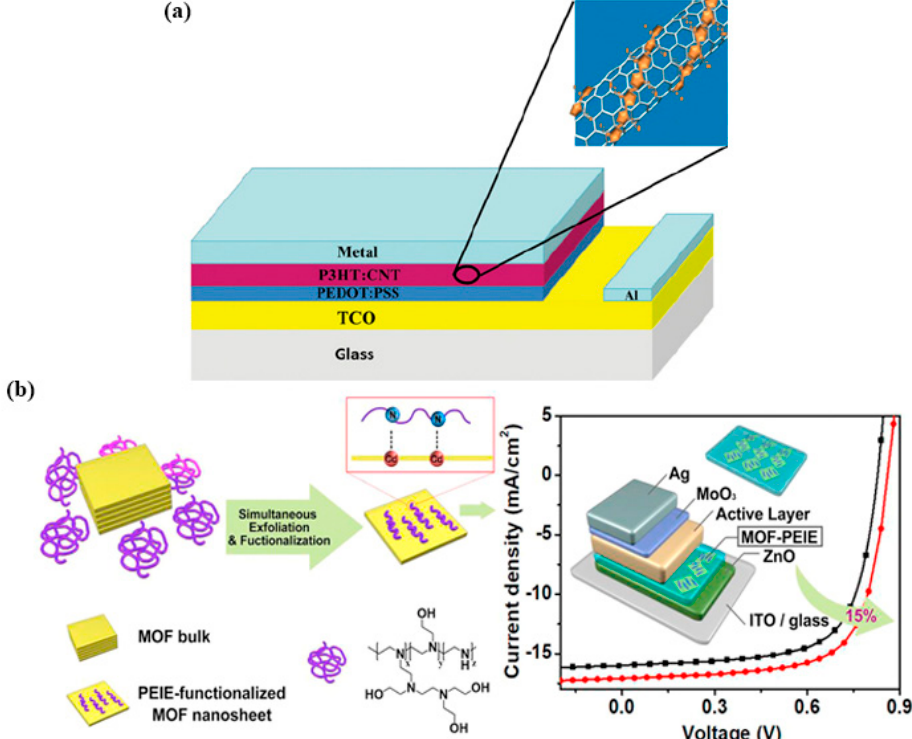
Figure 5. Graphical diagram of ( a ) standard organic basic cell using carbon nanotubes as an acceptor in the active layer [64]. ( b ) Preparation diagram of MOF-PEIE and its application in organic solar cells (OSC) [20].